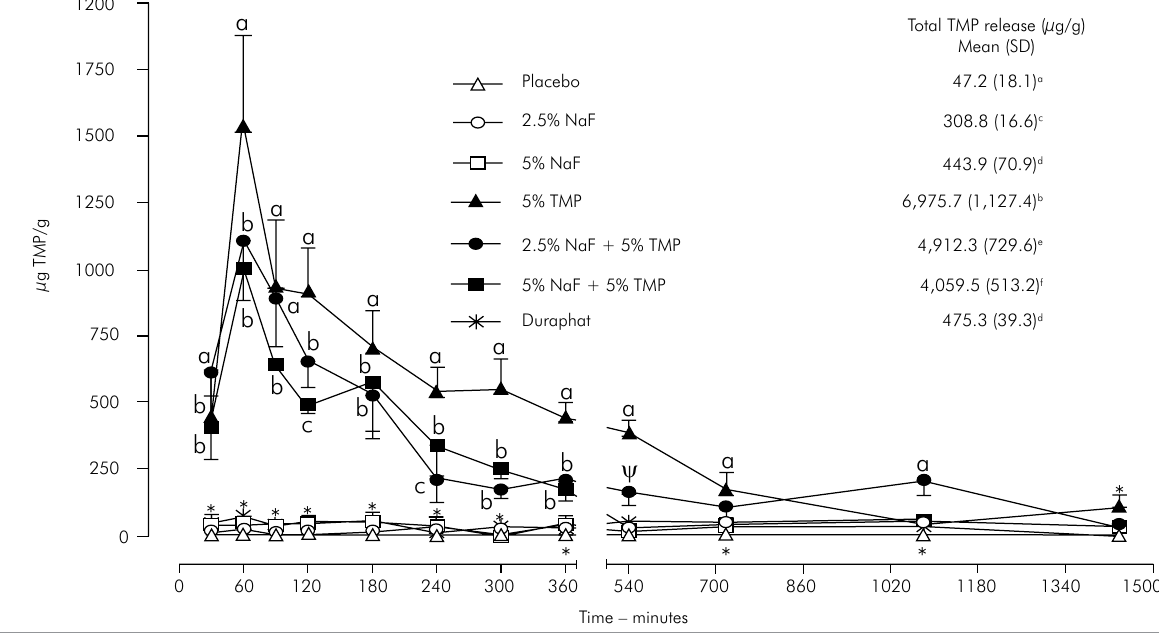
Figure 2. Time-course of TMP release from varnishes into artificial saliva (24 h). Vertical bars indicate standard error of the mean. * p > 0.05. Ψ p > 0.05, except for 2.5% NaF/5% TMP × Placebo (two-way repeated measures-analysis of variance and Student-Newman-Keuls’ test). Cumulative release of TMP analyzed by one-way analysis of variance/Tukey’s test (p < 0.05). Superscript letters indicate significant differences among the varnishes for each time point, as well as for cummulative